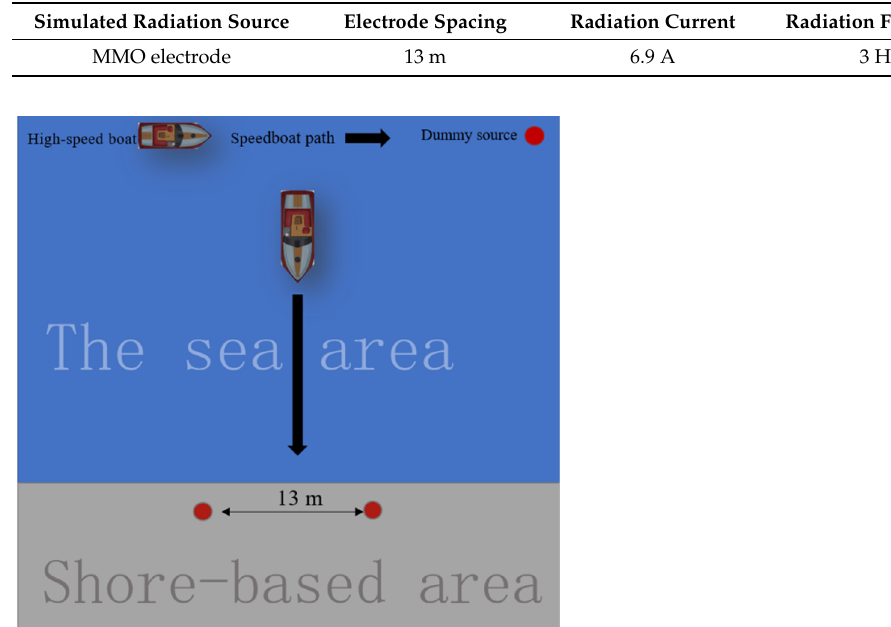
Figure 3. Schematic diagram of sea test: The speedboat moves from a distance to the simulated radiation source placed on the shore, the blue area is the sea area, the gray area is the shore the water depth in the test area was around 5 m.